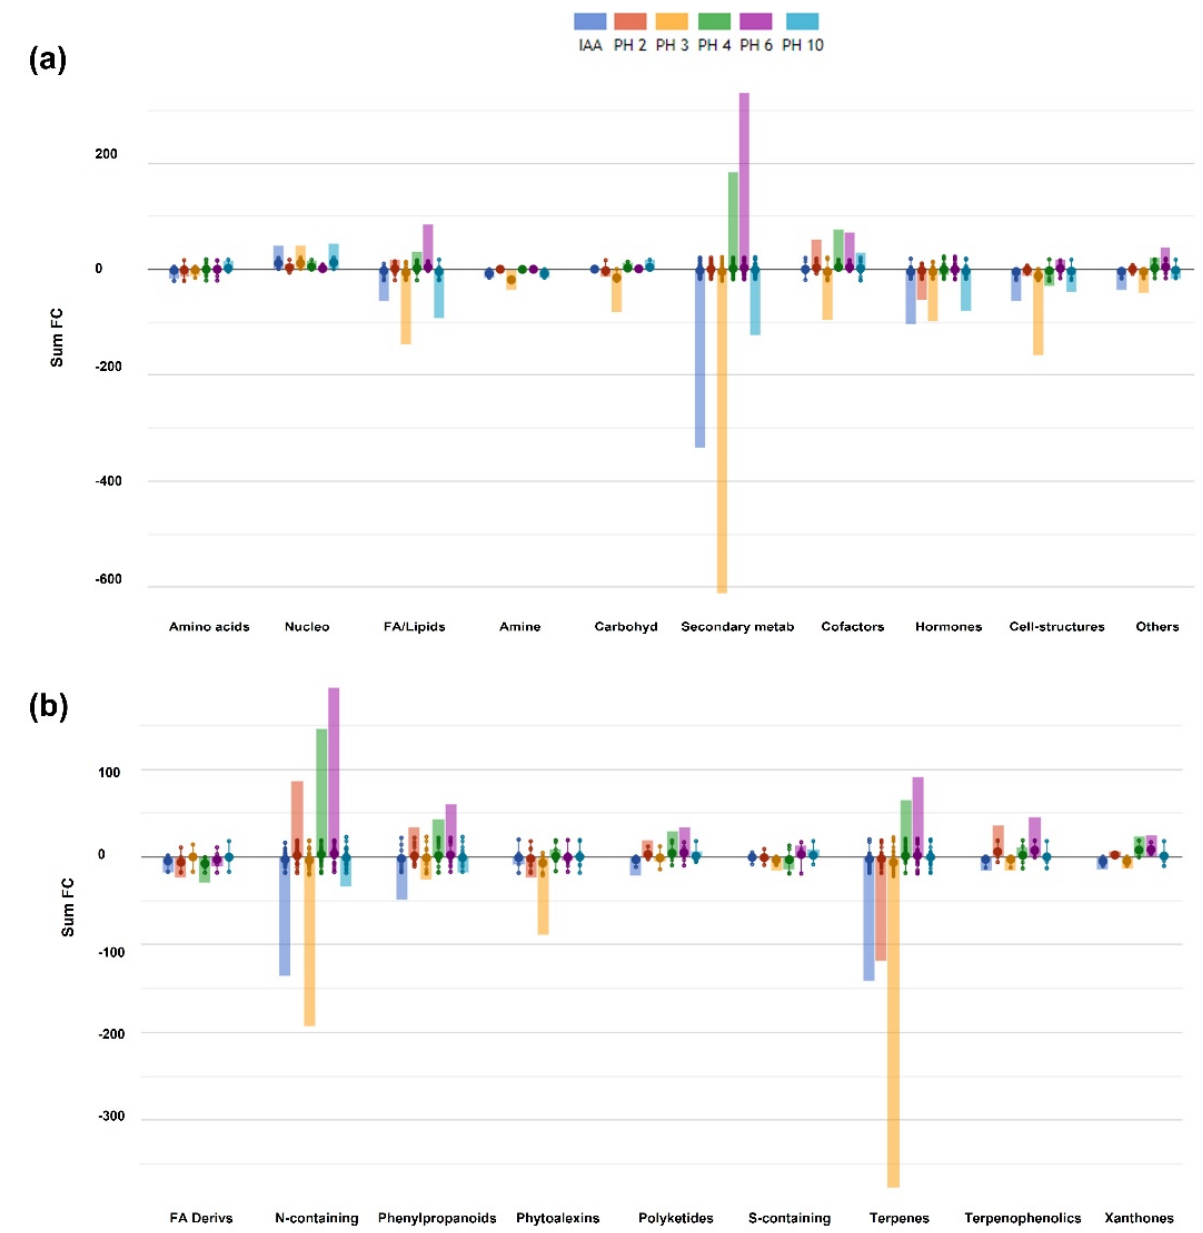
Figure 4. Summary of the biosynthetic pathways ( a ) and secondary metabolism ( b ) processes affected by protein hydrolysates (PHs) applications. The dataset produced through UHPLC-ESI/QTOF-MS was subjected to volcano plot analysis ( p < 0.01, fold-change > 3) and all the differential metabolites elaborated with the PlantCyc Pathway Tool (https://www.plantcyc.org, accessed on 24 March 2020). Five biological replicates were analysed for each treatment. Indole-3-acetic acid 1 mM (IAA) was used as positive control. The x -axis represents each set of subcategories while the y -axis corresponds to the cumulative fold-change that is depicted by the height of the bar. Each dot represents the individual log FC of a single compound. The large dots are the average (mean) of all data values for metabolites within the same subcategory. Nucleo: nucleoside and nucleotide biosynthesis; FA/Lipids Syn: fatty acid and lipid biosynthesis;